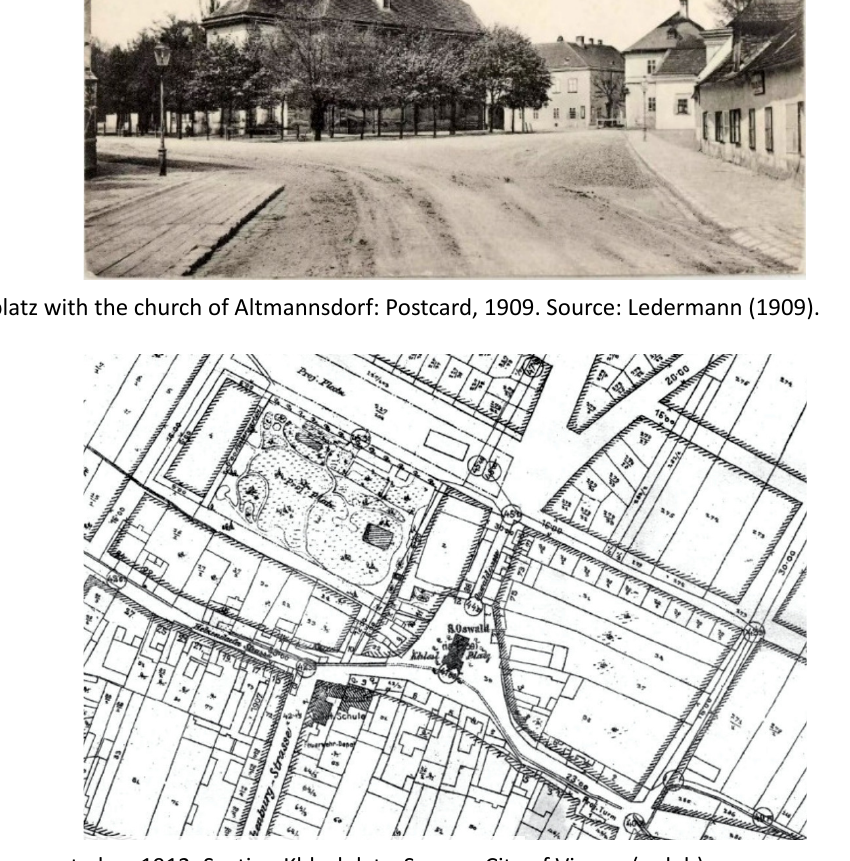
Figure 10. Development plan, 1912: Section Khleslplatz. Source: City of Vienna